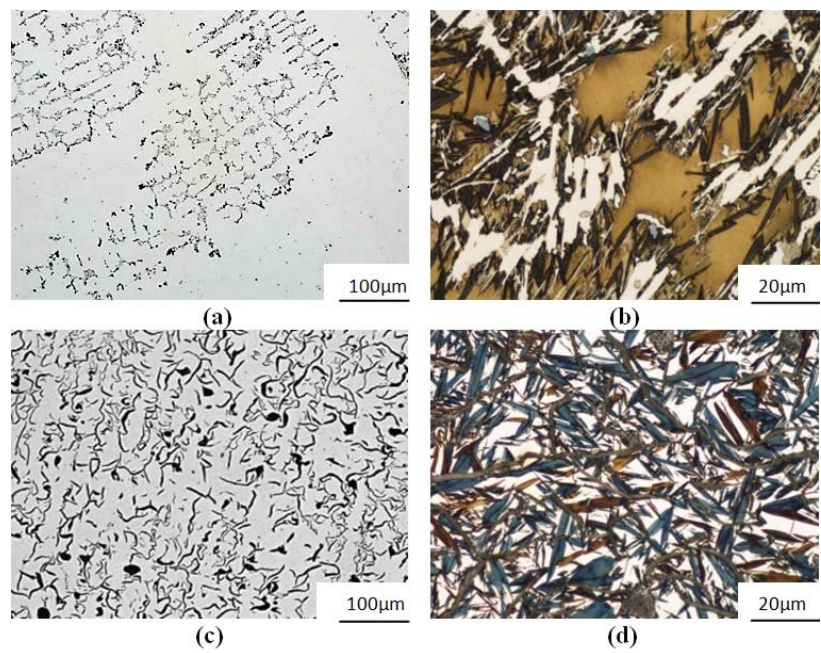
Figure 2. Cast iron Ni ‐ Mn ‐ Cu: ( a ) No. 4— subeutectic with a small number of interdendritically arranged colonies of ID7 graphite; ( b ) No. 4— chilled after partial austenite ‐ martensite transition (Equ Ni = 13.6%, S C = 0.66); ( c ) No. 5— graphite colonies characteristic for eutectic alloy IA5 with graphite features indicating interdendritic arrangement type E; ( d ) No. 5 —martensite after the transformation (Equ Ni = 11.6%, S C = 0.98). ( a , c ) unetched; ( b , d ) etched with Mi1Fe. Alloy No. 6 is a typical eutectic grey cast iron (S C = 0.98), with a pearlitic structure and a hardness of 210 HBW. Percentage of the observed straight flake graphite IA3/4 (acc. to EN ‐ ISO 945) was ca. 12%, see Figure 3.